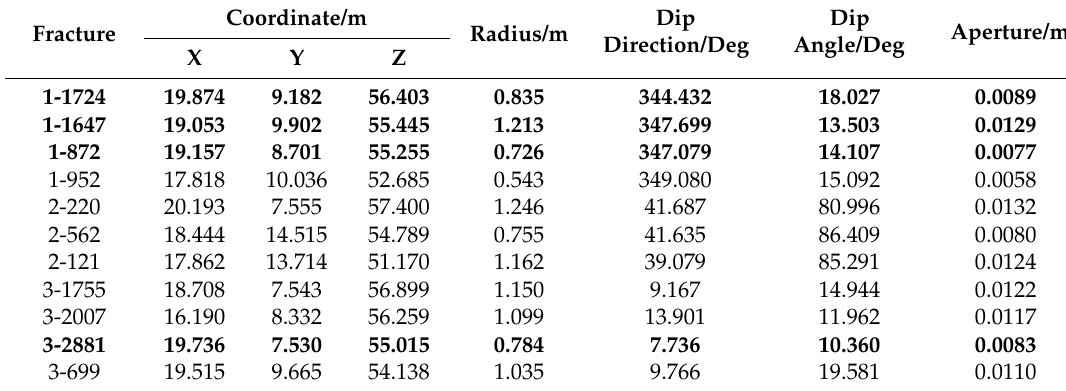
Figure 8. Fluid calculation model: ( a ) fracture geometrical model, ( b ) fracture grid model, and structural calculation model: ( c ) rock mass geometrical model, ( d ) rock mass grid model. Table 2. Geometric parameters of the computation fracture mode.